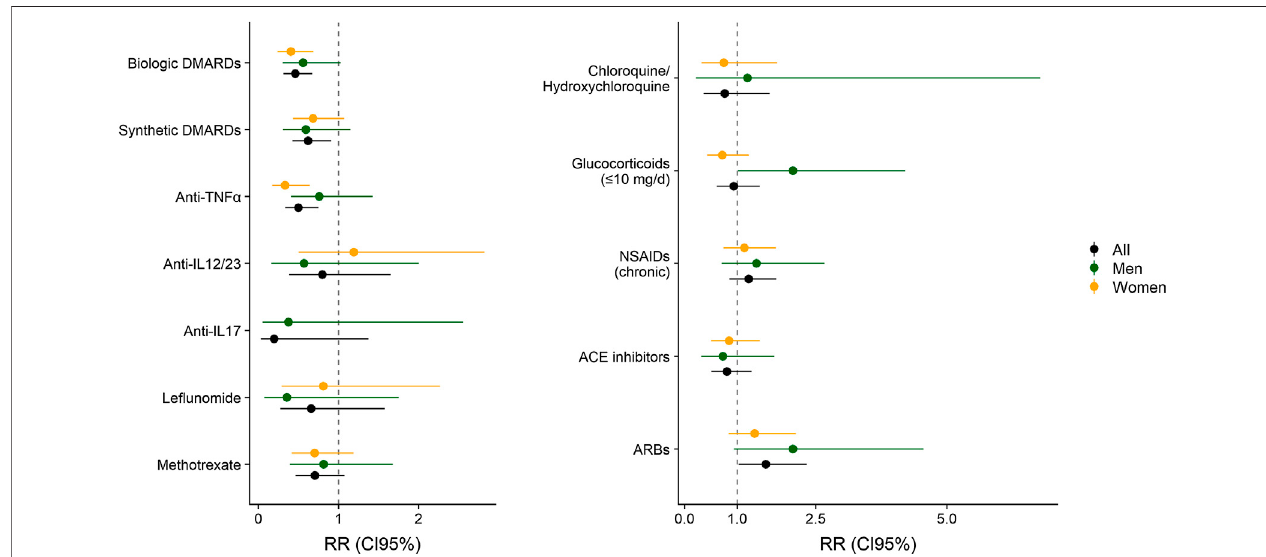
FIGURE 1 | Relative Risk (RR) with 95% Con fi dence Interval (CI 95%) of COVID-19 according to the exposure to different treatments, adjusted by sex, age, CV disease, diabetes, pulmonary disease, chronic kidney disease and active cancer or treatments. The aggregated effect of biologic DMARDs, syntheticDMARDs, glucocorticoidsandNSAIDsareobtainedfromModel1.EstimatesforAnti-TNF α ,Anti-IL6/12/17/24(anti-pro-in fl ammatoryILs),methotrexate,ACEinhibitors,ARBsand chloroquine/hydroxychloroquine are obtained from Model 2. Model 1 and 2 are represented in Tables 5 , 6